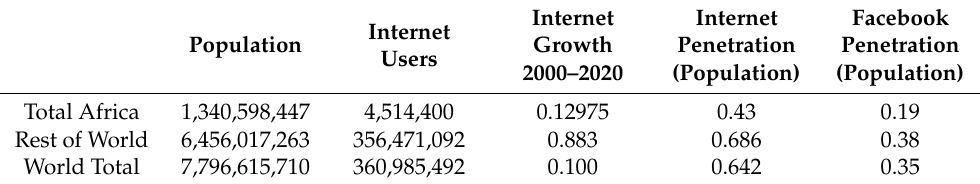
Table 3. Trends in internet and Facebook users as of December 2020. Internet Internet Population Users